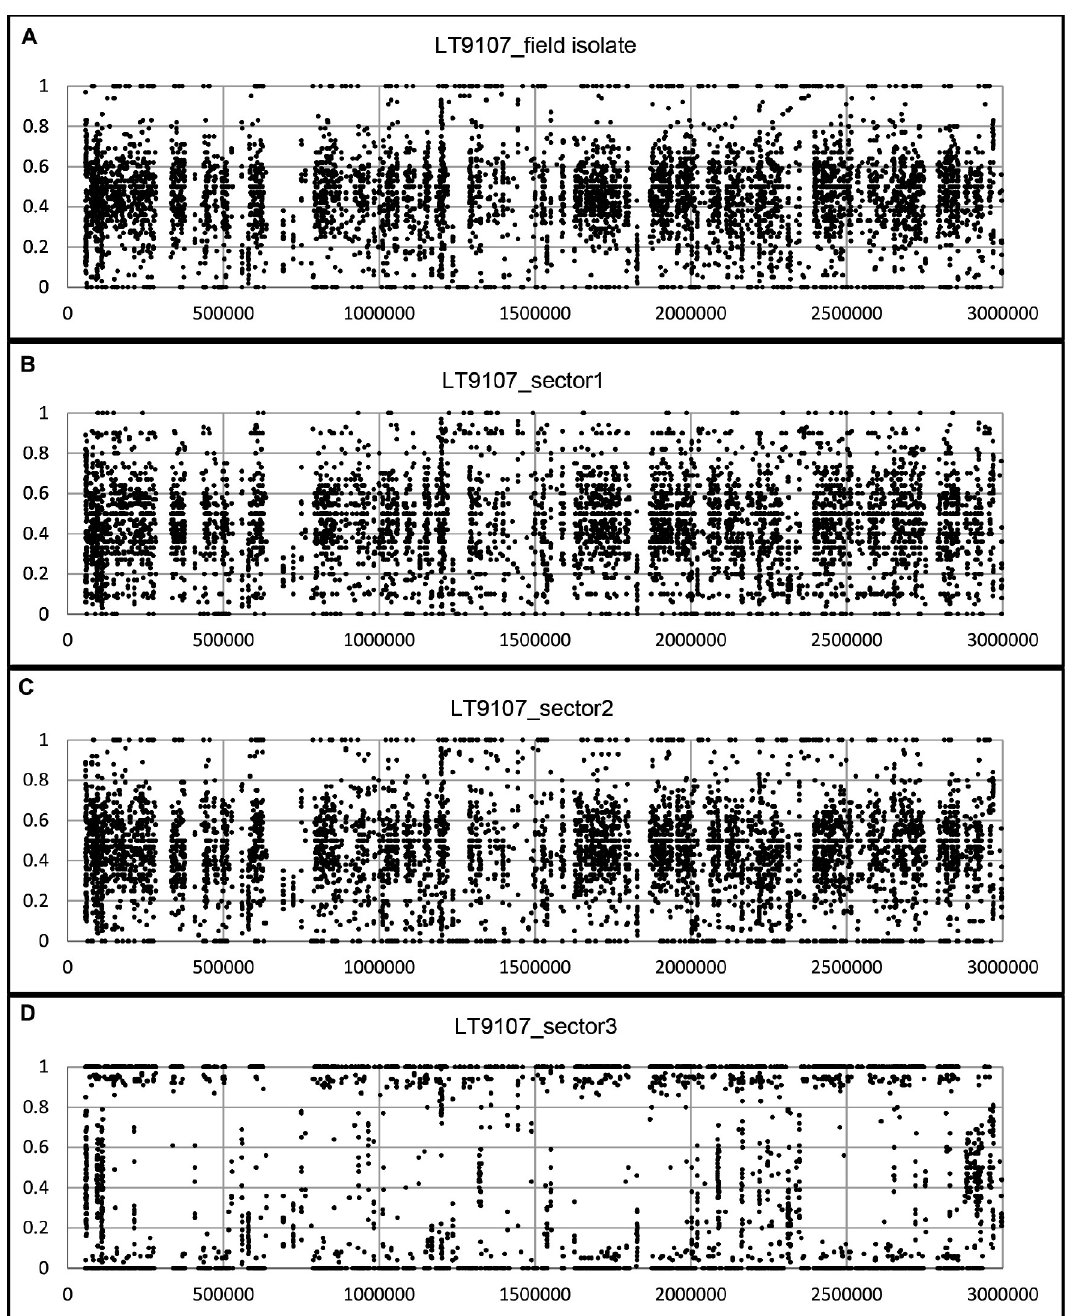
Fig 7. Heterozygous allele frequencies across 3Mbp of linkage group 8 for a single-zoospore derived isolate of Phytophthora capsici recovered from pepper in China and subcultures from mycelium sectoring on agar media. Sequencing depth indicates isolates are diploid. Note the wide distribution of allele frequencies for A-C and fixation of most of the alleles in D (copy neutral loss of